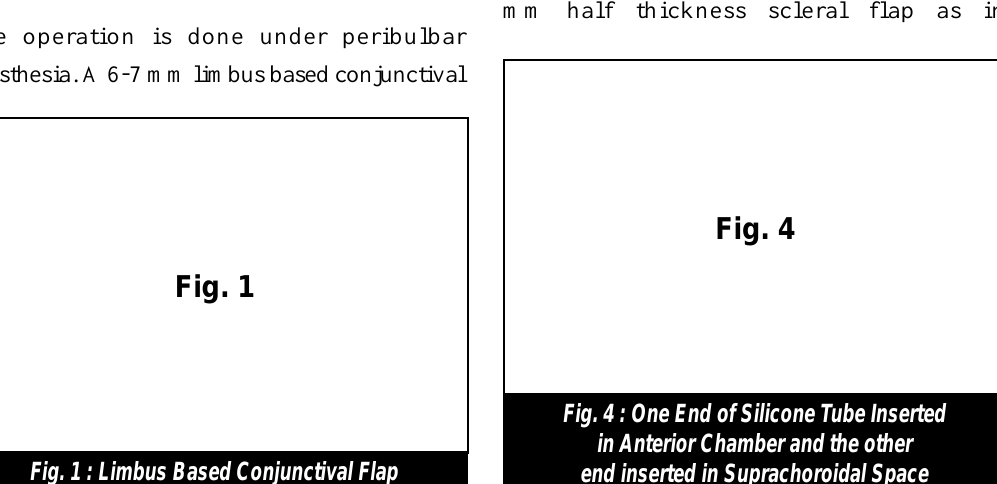
in Anterior Chamber and the other end inserted in Suprachoroidal